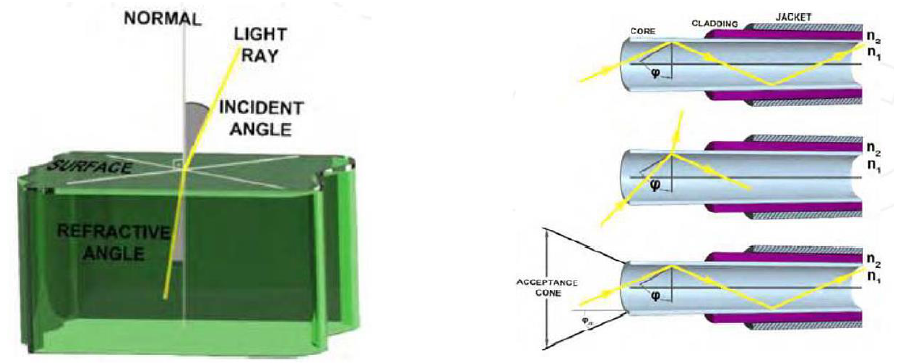
Figure 7. An example of fibre-optic biosensors (adapted from